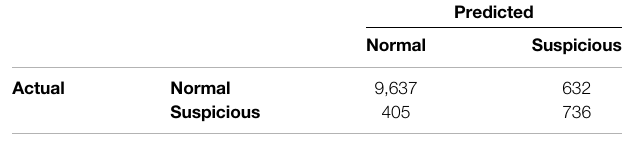
TABLE 8 | Fast strategy confusion matrix.